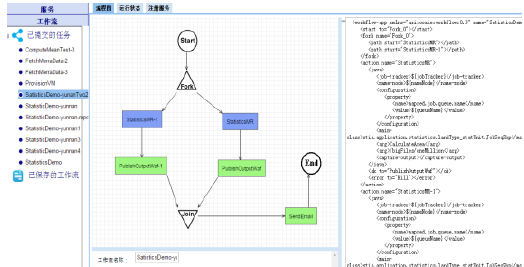
Figure 5.4. Service chaining engine Figure 5. Spatiotemporal Cloud Platform (Figure 5.1., Figure 5.2., Figure 5.3., Figure 5.4. )